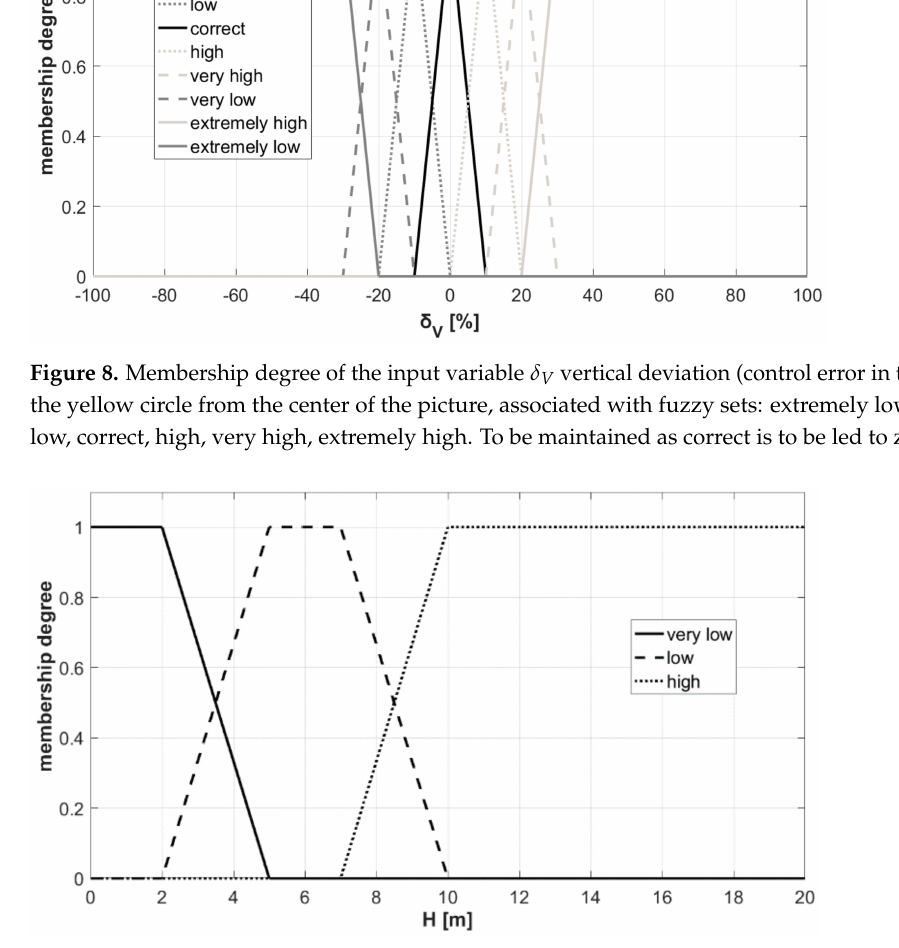
Figure 9. Membership degree of the input variable height H associated with fuzzy sets: very low, low,